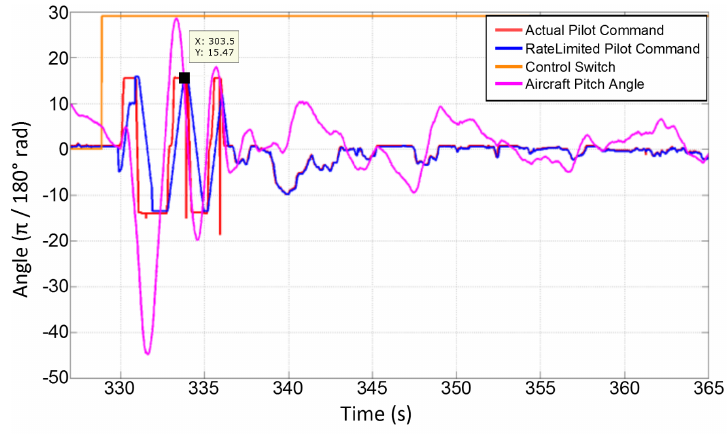
Figure 20. Flight experiments for 31.46 ◦ /s elevator rate limit.